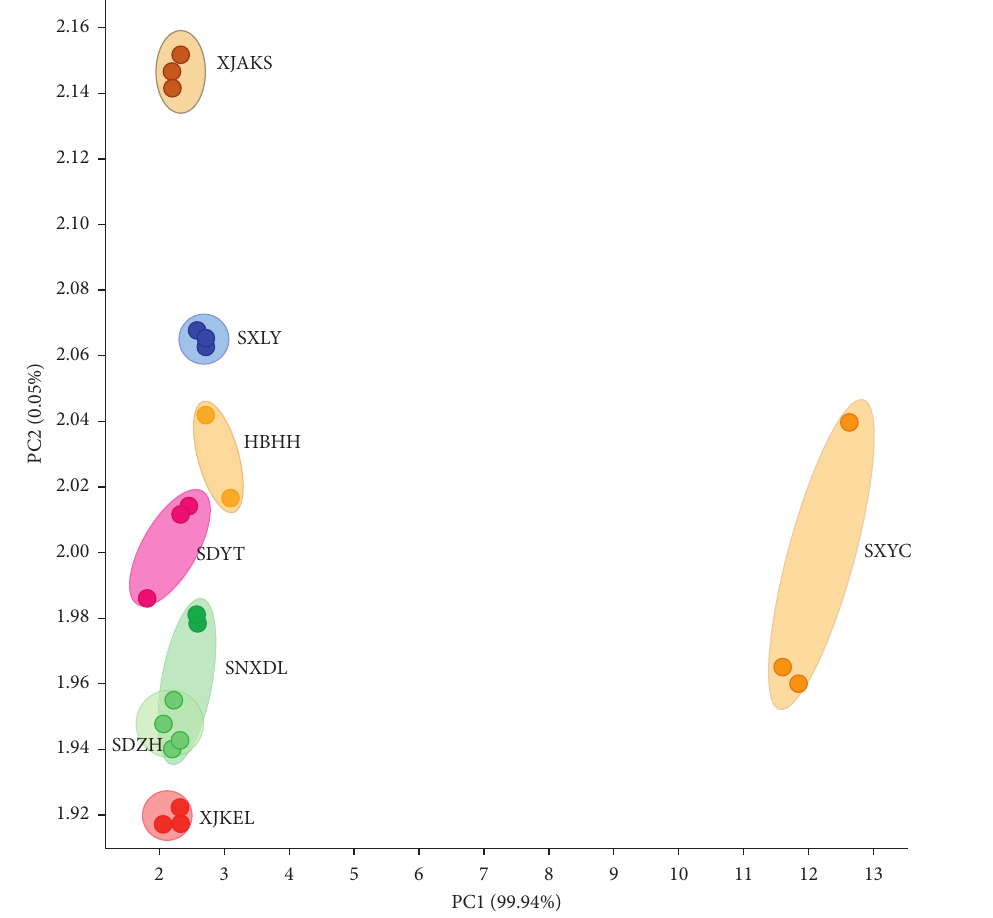
Figure 4: PCA results of eight regions of winter jujubes differentiated by Table 3: Sensors and response characteristics of E-nose.